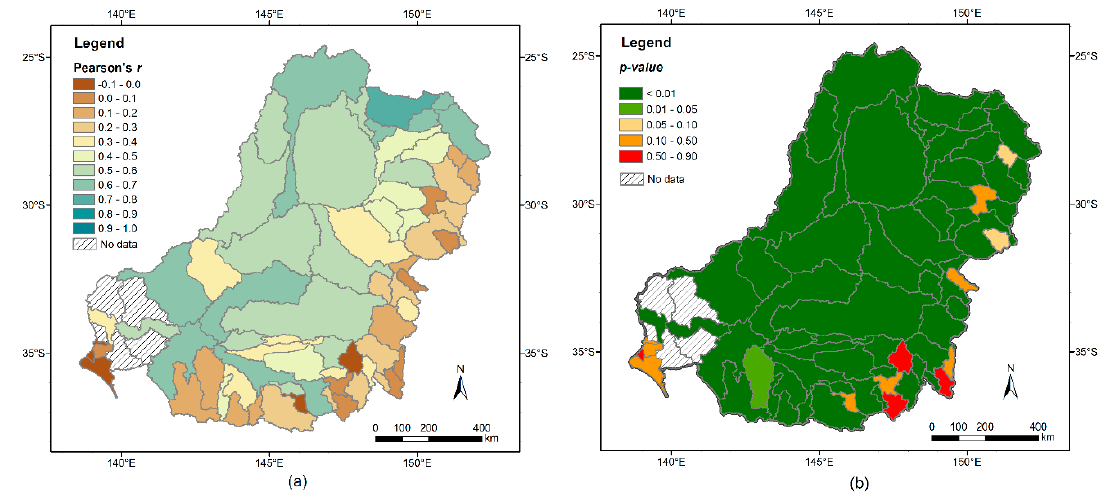
Figure 8. Correlation between observed flow and remotely sensed inundation in each zone. ( a ) Pearson’s r ; ( b ) p -value.